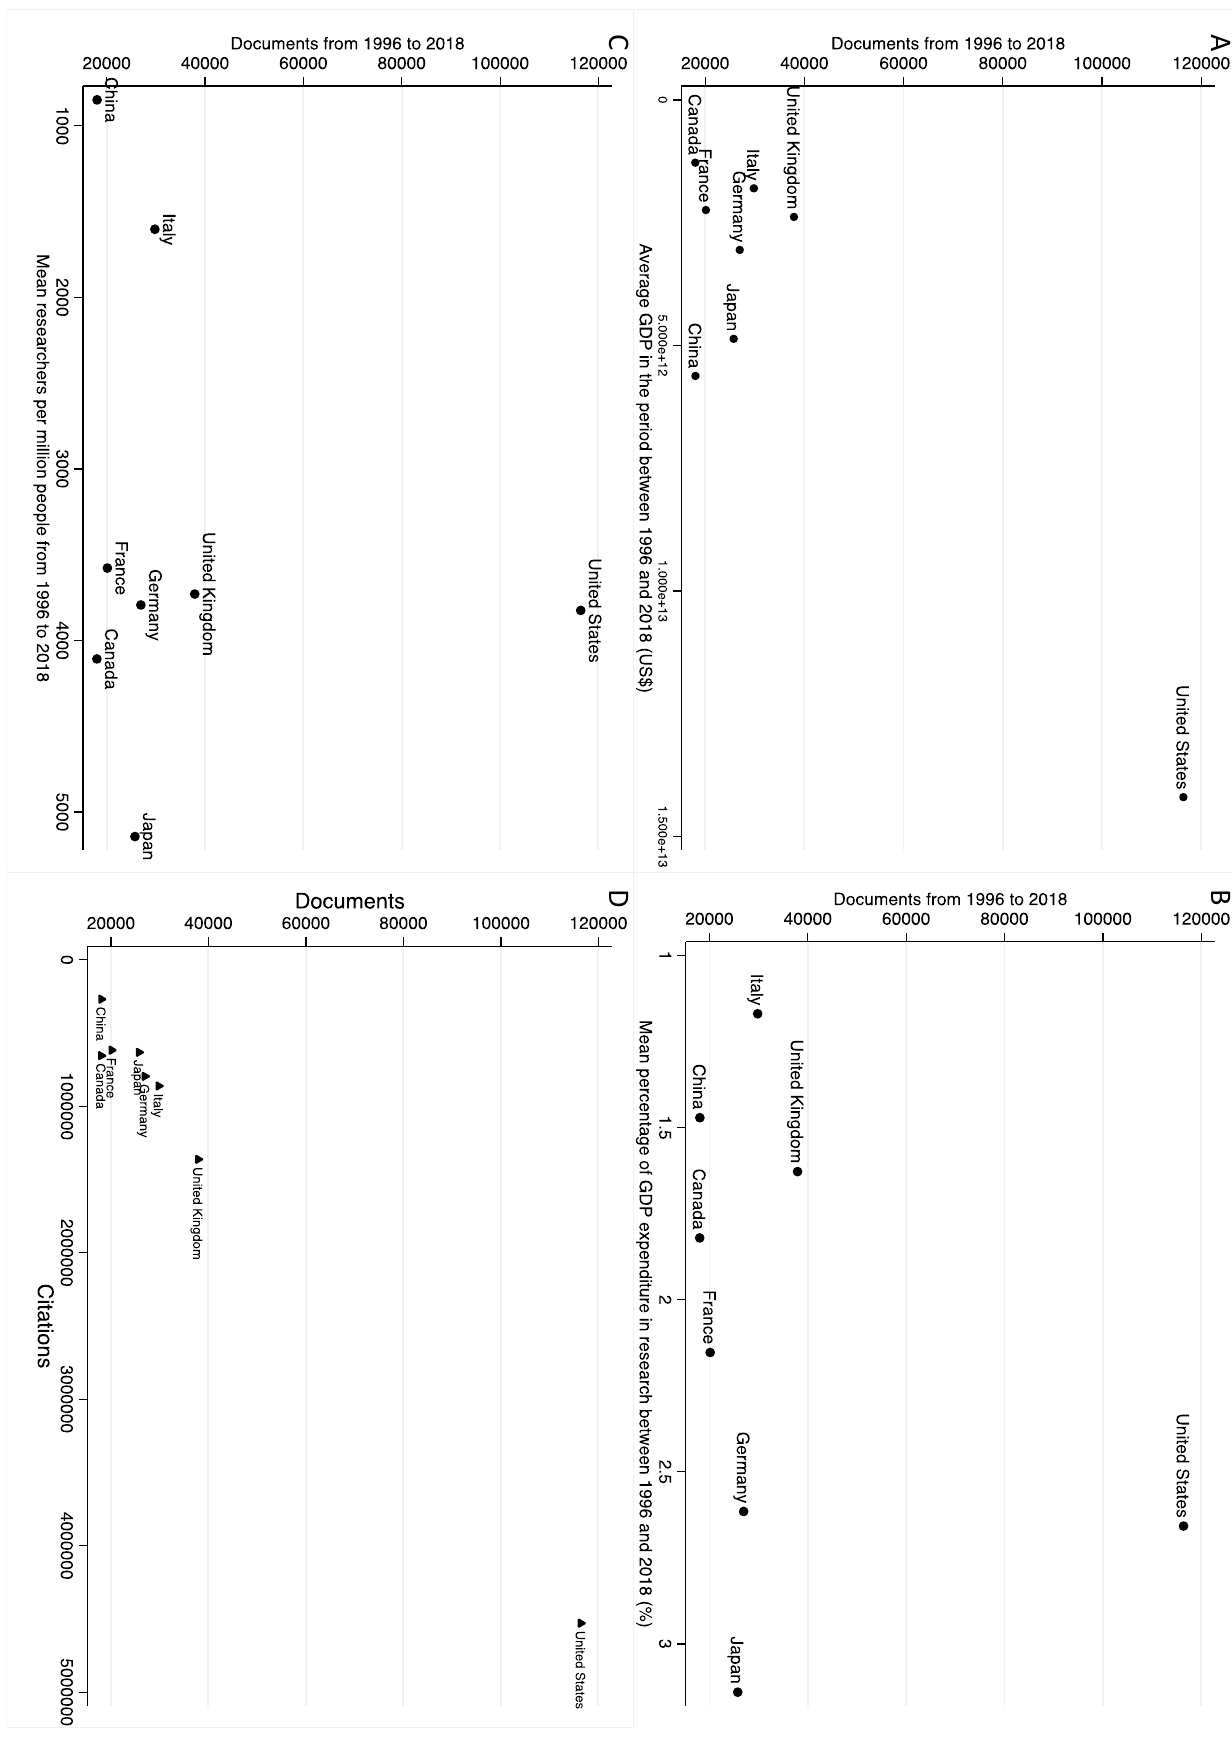
Figure 1. Outputs of endocrinology and diabetes research papers among the top eight countries, between 1996 and 2018, in relation to the mean GDP (A), the percentage of GDP spent in research and development (B), the number of researchers per million people (C) and the citation counts